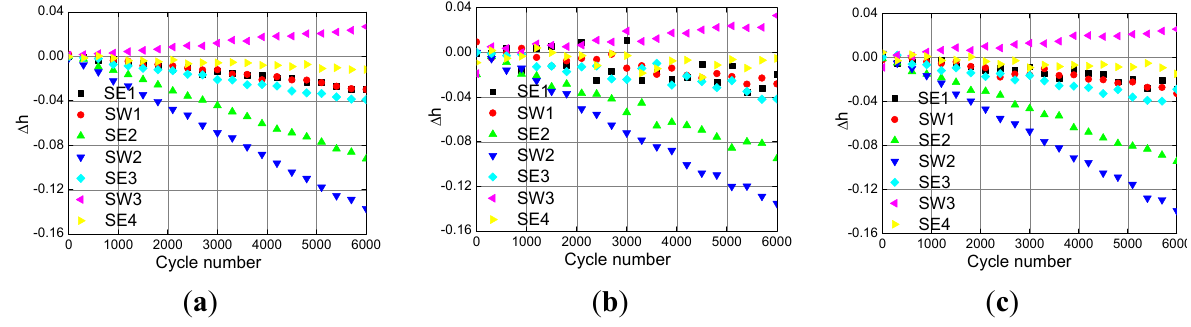
Figure 8. Health parameters estimation with non-Gaussian noise under the gradual degradation. ( a ) The EKF; ( b ) the PF; ( c ) the cEKPF.